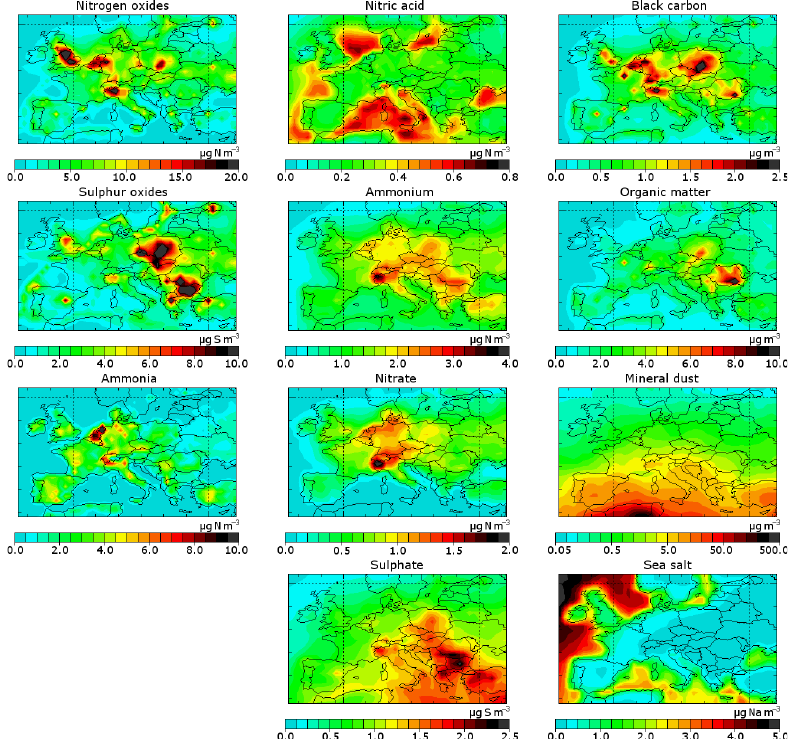
Fig. 1. Modelled surface concentrations of the aerosol tracers and precursor gases. Note that the colour scale used for mineral dust is logarithmic. Nitrogen oxides include NO, NO 2 , Peroxyacytyl nitrate (PAN), NO 3 , HNO 4 and N 2 O 5 , but no nitric acid or aerosol nitrate. Sulphur oxides include SO 2 and H 2 SO 4 , but no aerosol sulphate. All values are averaged over 2006.